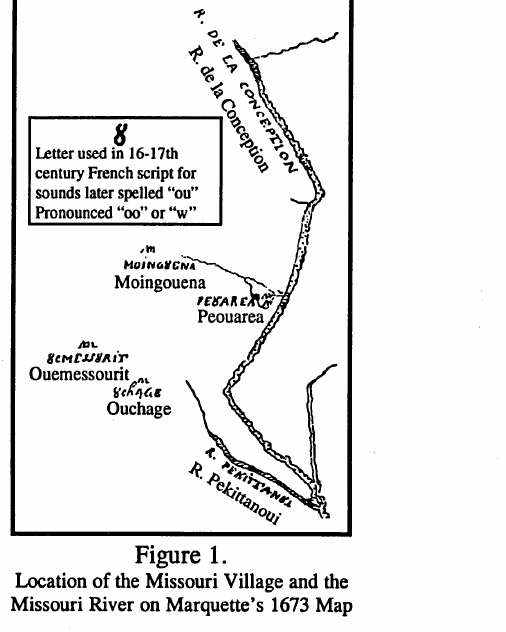
Location of the Missouri Village and the Missouri River on Marquette's 1673